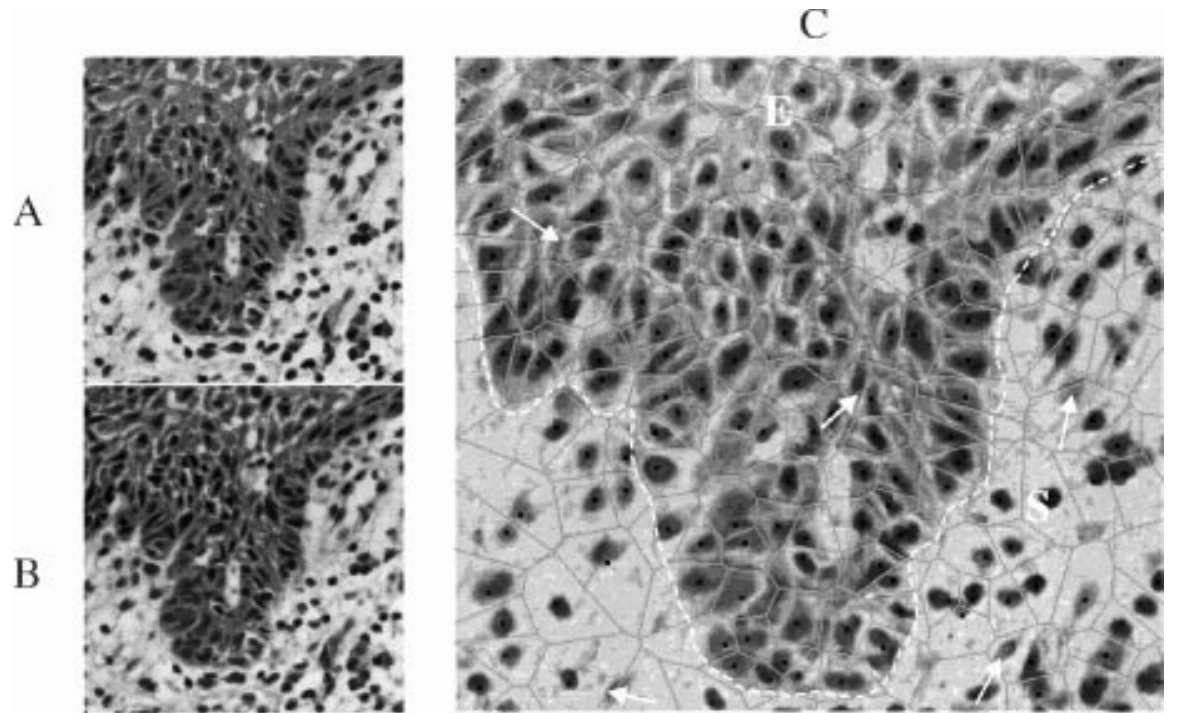
Fig. 3. An epithelial island from the part of an oral squamous cell carcinoma (E, Panel C) bordering onto the underlying connective tissue (S, Panel C). Panel A is a detail from a HE stained section from the invasive front. The corresponding grey level image is shown in Panel B. Panel C shows Voronoi polygons superimposed on the enlarged grey level image shown in Panel B. The pointlike seed are given as black dots superimposed on the cell nuclei, and represent the geometrical centre of gravity of each nucleus. Each Voronoi polygon represents the area of influence of one pointlike seed, which in epithelial tissues roughly correspond to the extension of a cell. Some cell nuclei are missed (white arrows), but the overall precision in the segmentation is acceptable. The dotted line denotes the basal membrane, which in this case also comprises a part of the border of the window of analysis. The scale bar is 0.10 mm (400 (cid:2)